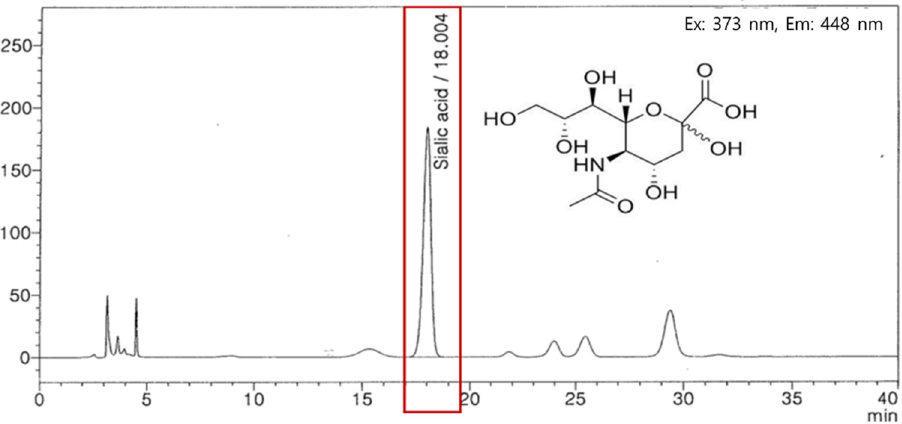
Figure 1. High-performance liquid chromatography analysis for sialic acid levels in